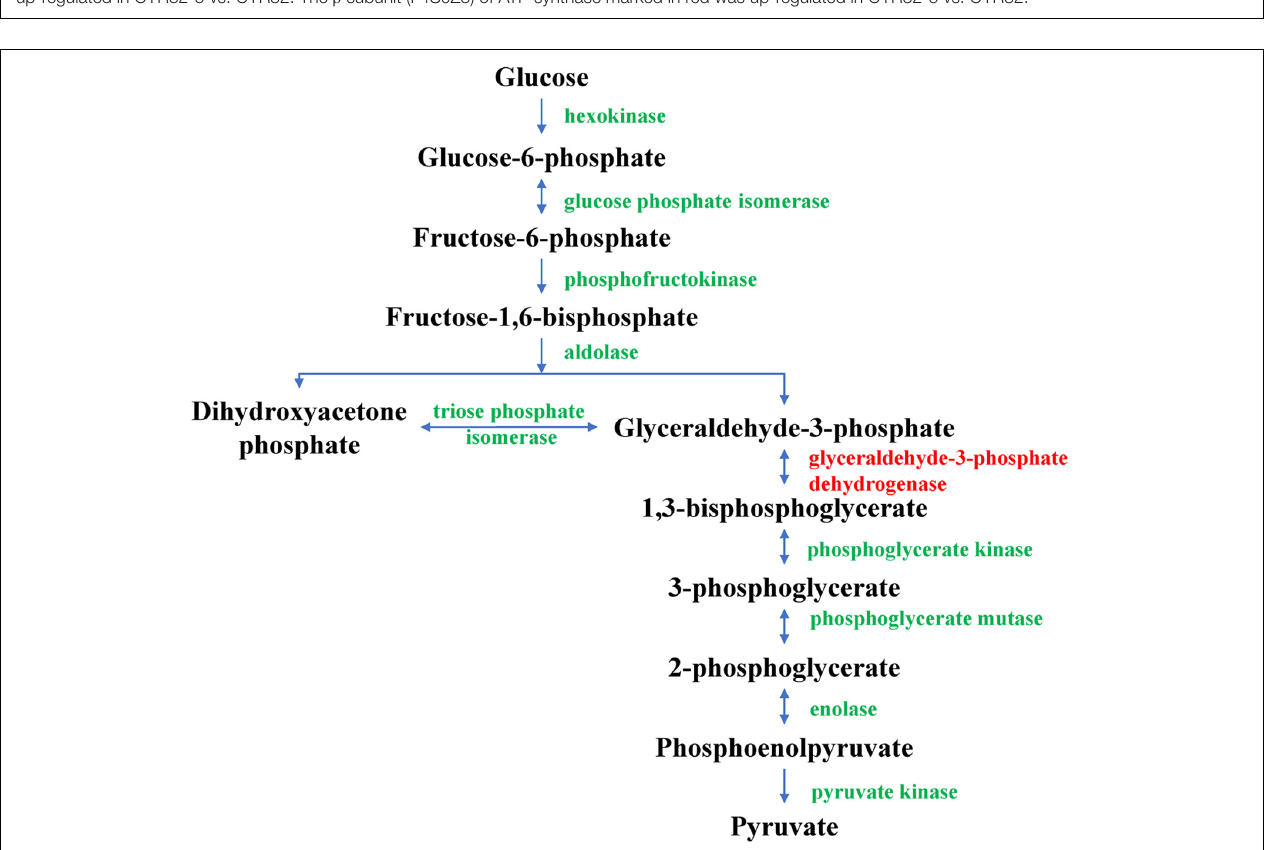
FIGURE 6 | Glycolysis pathway. The glyceraldehyde-3-phosphate dehydrogenase marked in red was found to be up-regulated in CYR32-61 vs.